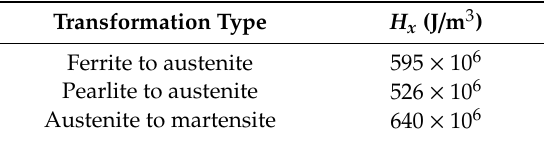
Table 2. Latent heat changes in phase